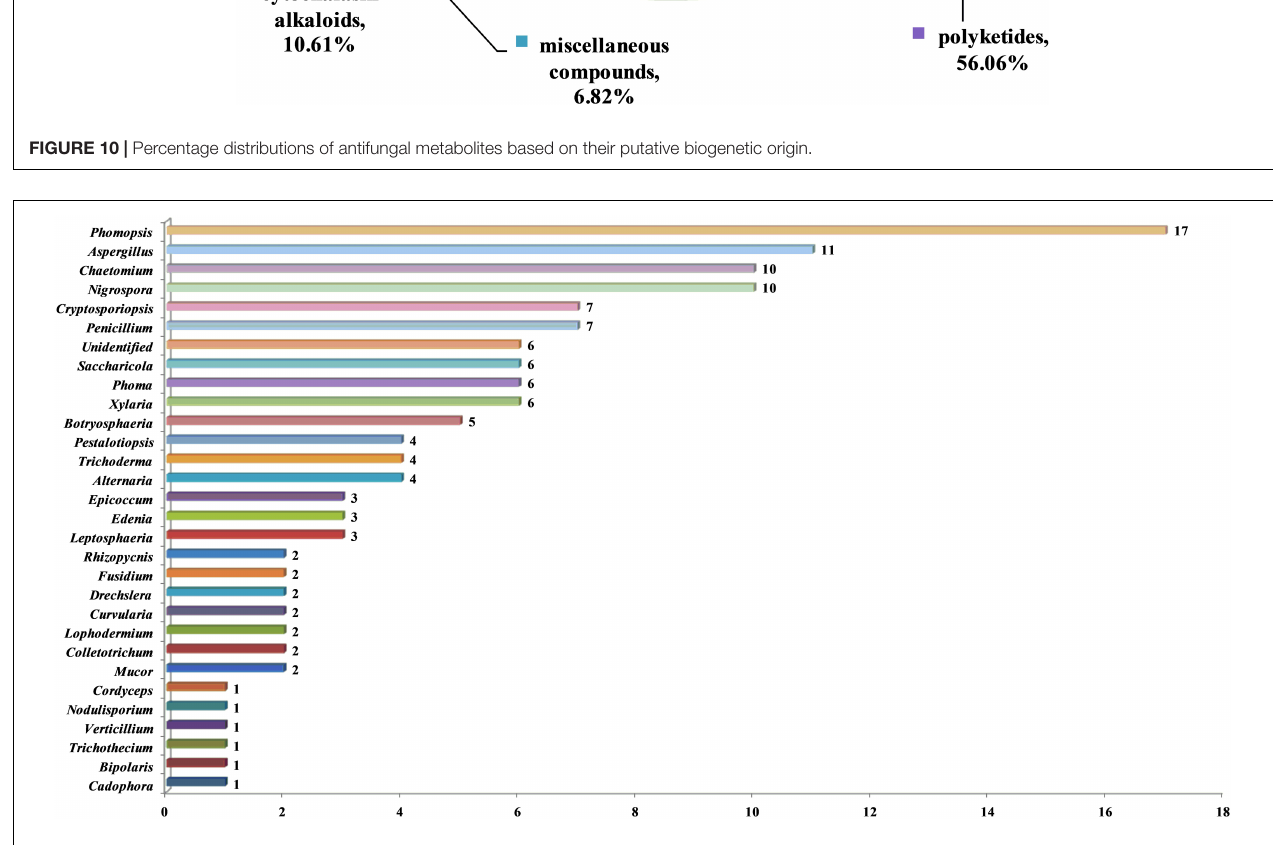
FIGURE 11 | Antifungal metabolites characterized from various producing